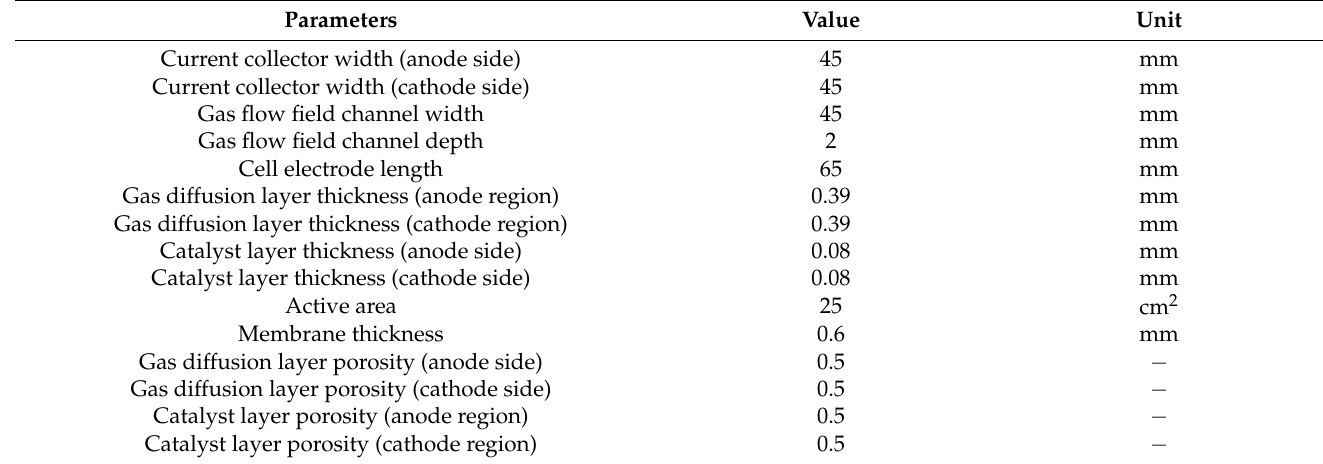
Table 1. Geometry